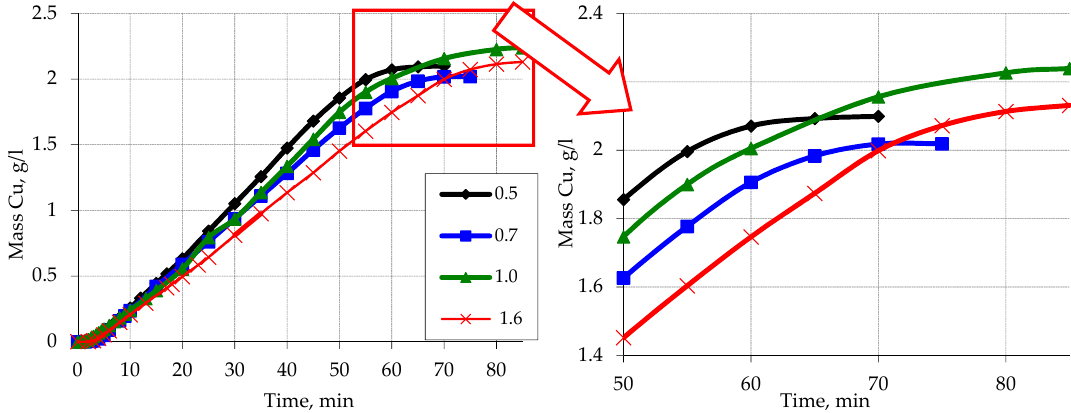
Figure 11. Kinetic curves of copper ion reduction on the activated and washed surface of polypropylene depending on the particle size. Concentration (mmol / L): NaOH–560; CuSO 4 –48; EDTA-Na 2 –67; formaldehyde–366.